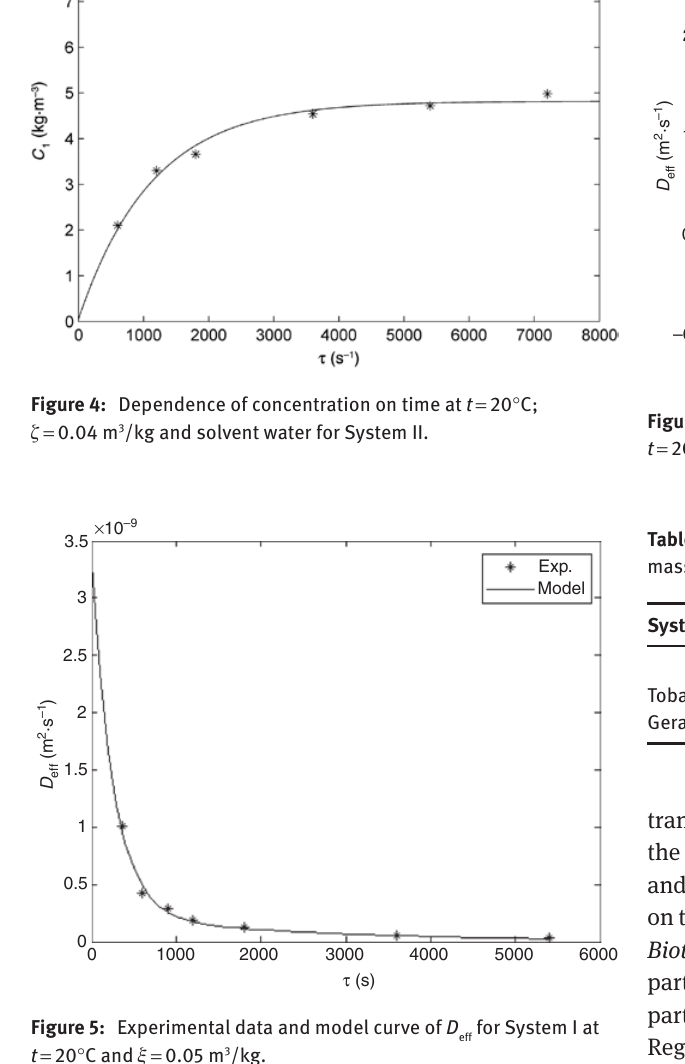
Figure 5: Experimental data and model curve of D t = 20 ° C and ξ = 0.05 m 3 /kg.